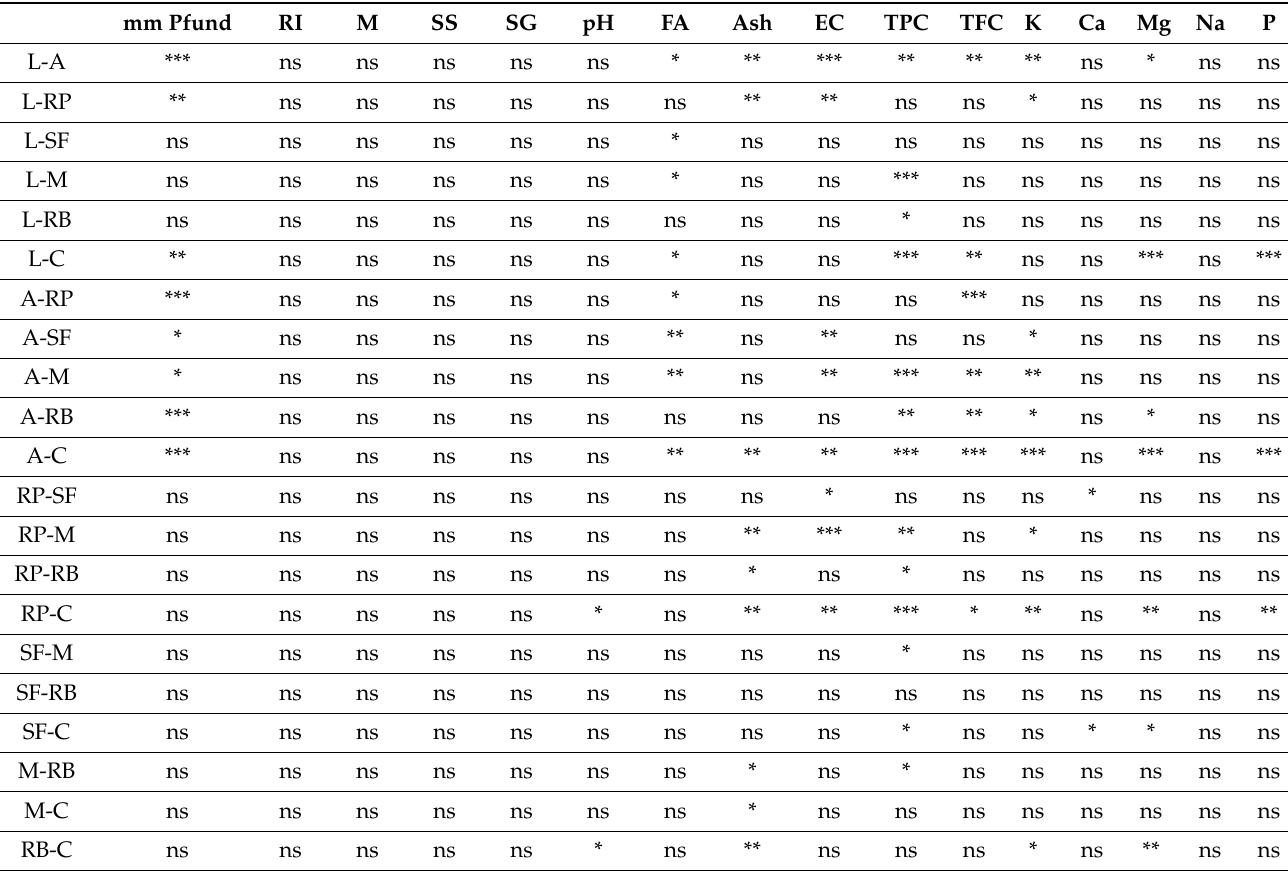
Table 5. Analysis of variance (ANOVA) for the determined quality parameters (pairs of honey types).